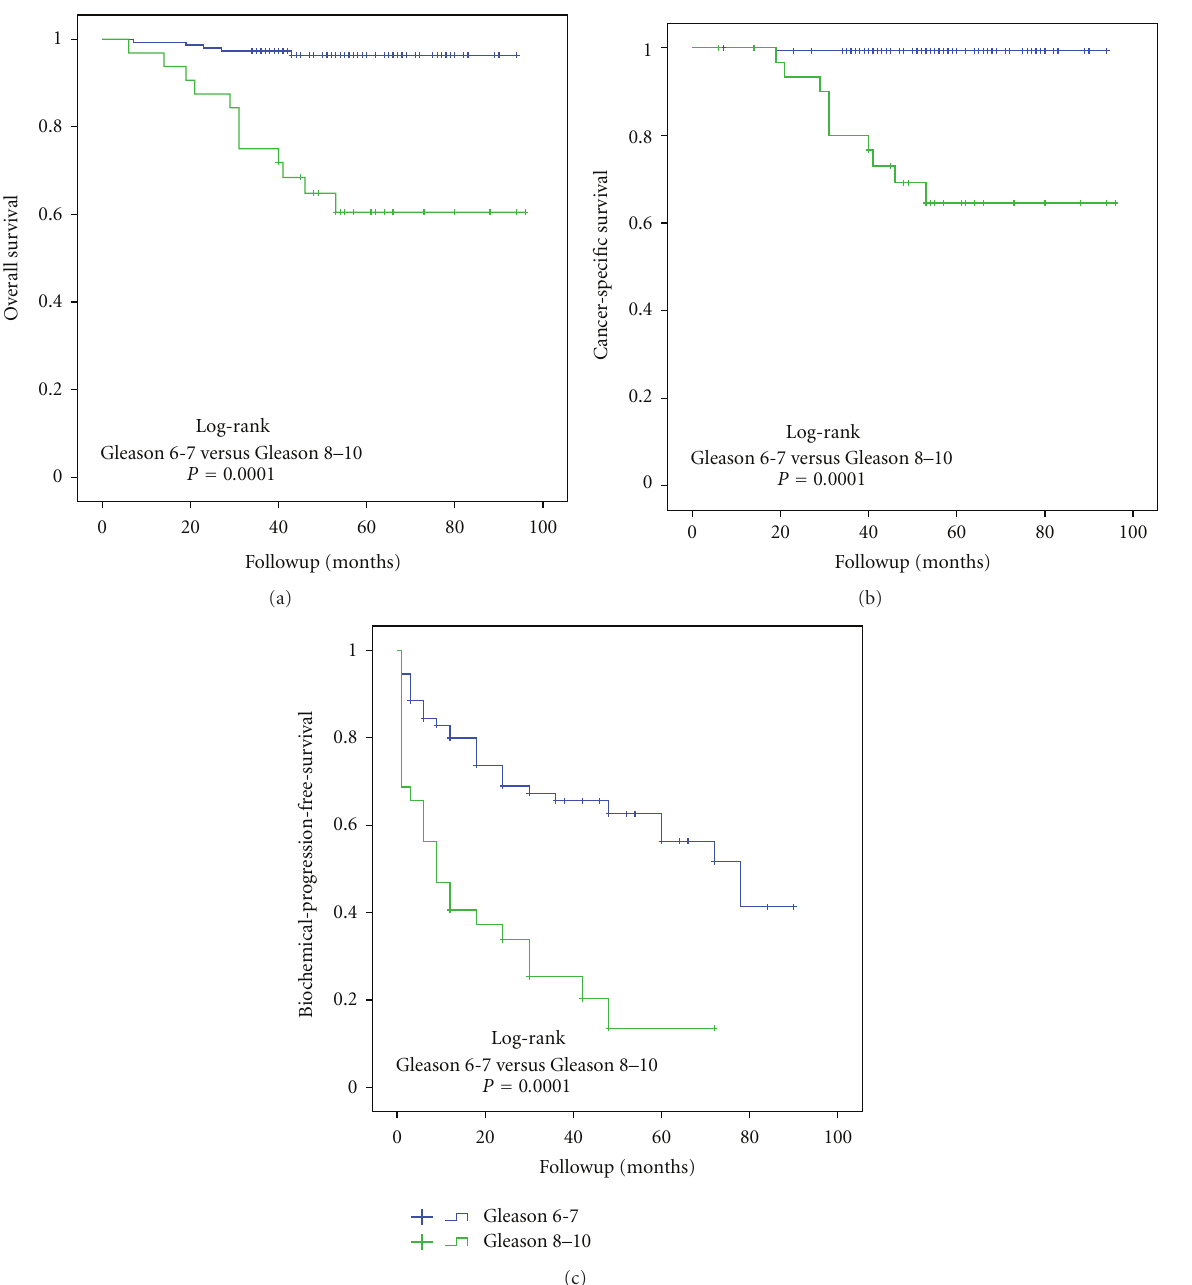
Figure 3: The Kaplan-Meier analysis with log-rank test for overall (a), cancer-specific survival (b), and biochemical-progression-free survival (c) stratified for Gleason score